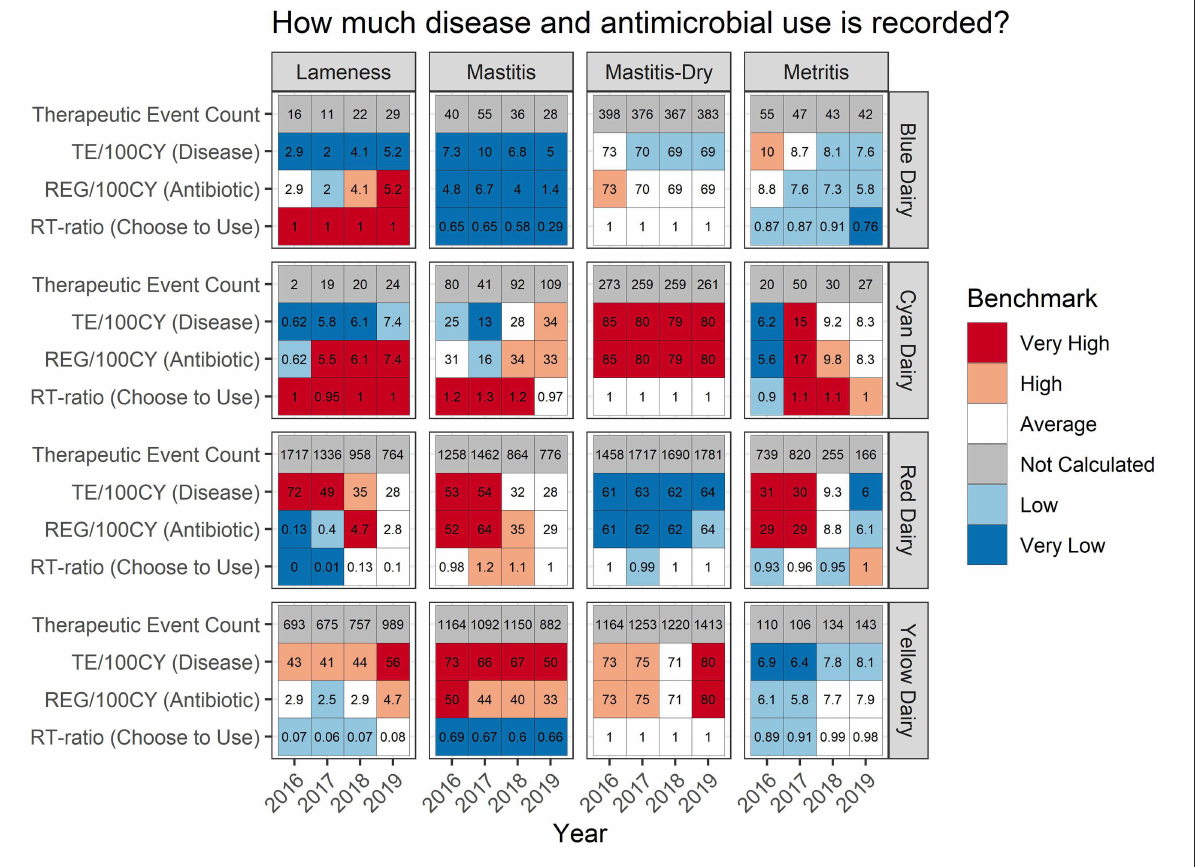
FIGURE4 For each measure listed on left the value is reported numerically within the cell. The background color indicates how that value ranks compared to other participating dairies.